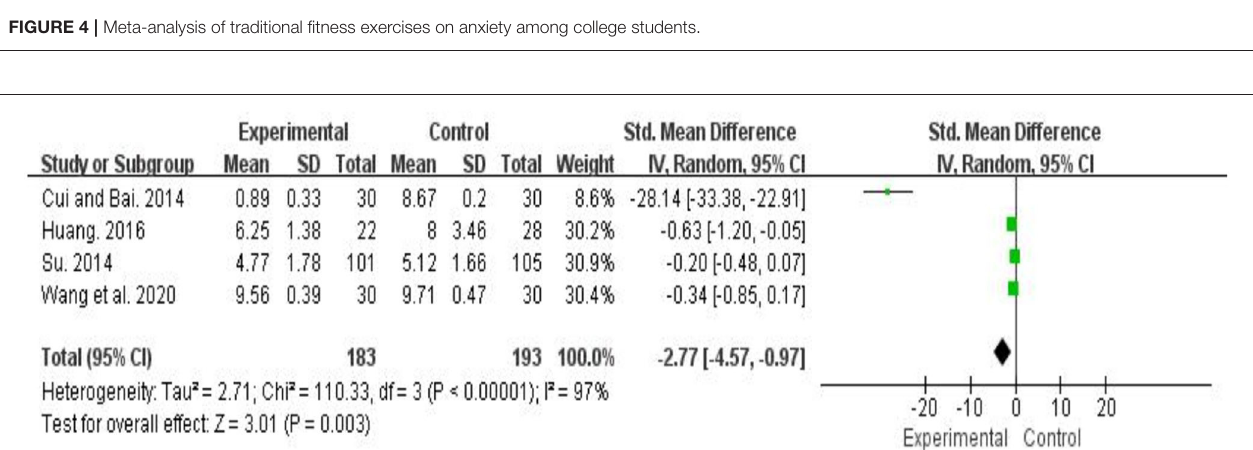
Frontiers in Psychology |